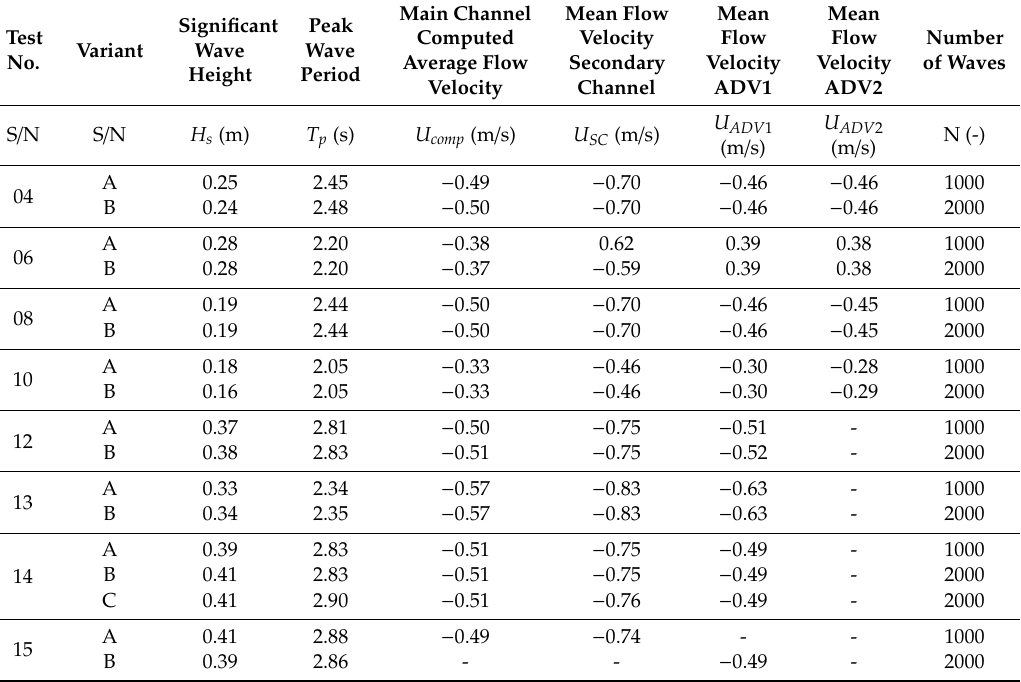
Table 5. Damage development measured conditions.